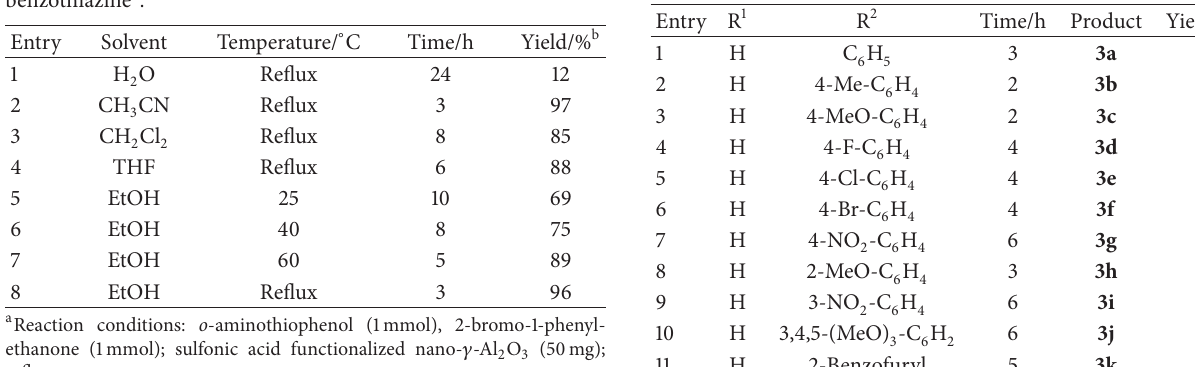
Table 3: Preparation of 3-substituted-2 H -1,4-benzothiazines a .